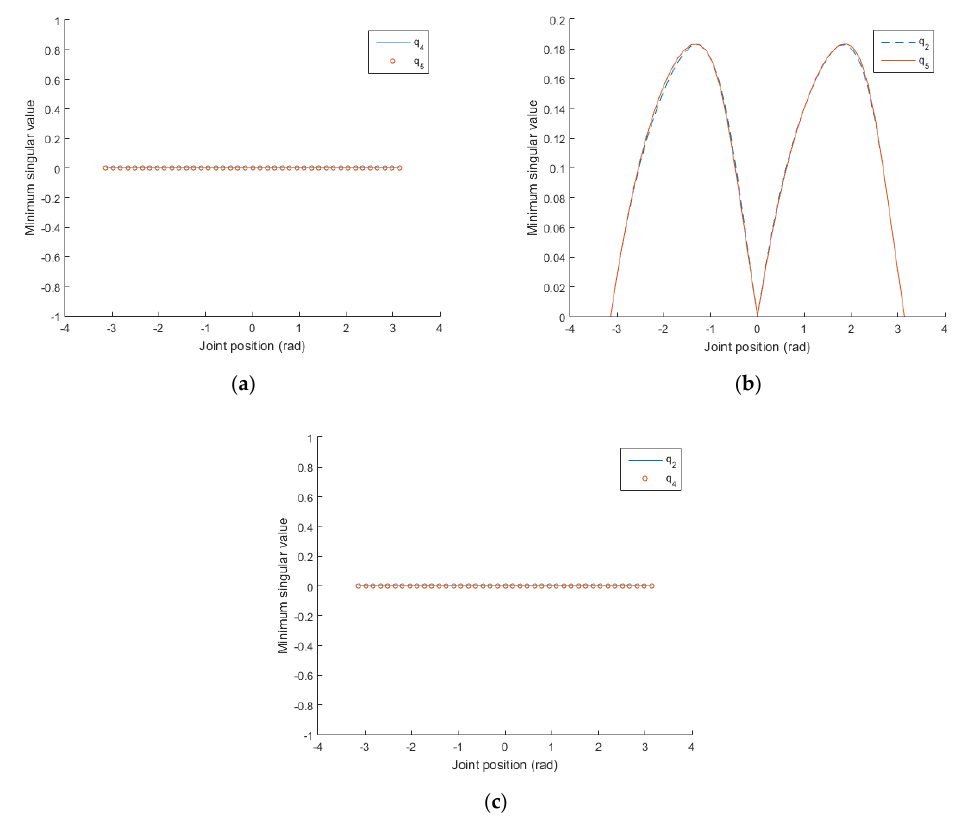
Figure 3. ( a ) Setting q 2 = 0, ± π rad, the distributions of the minimum singular values with the changes in q 4 and q 5 ; ( b ) setting q 4 = 0, ± π rad, the distributions of the minimum singular values with the changes in q 2 and q 5 ; ( c ) setting q 5 = 0, ± π rad, the distributions of the minimum singular values with the changes in q